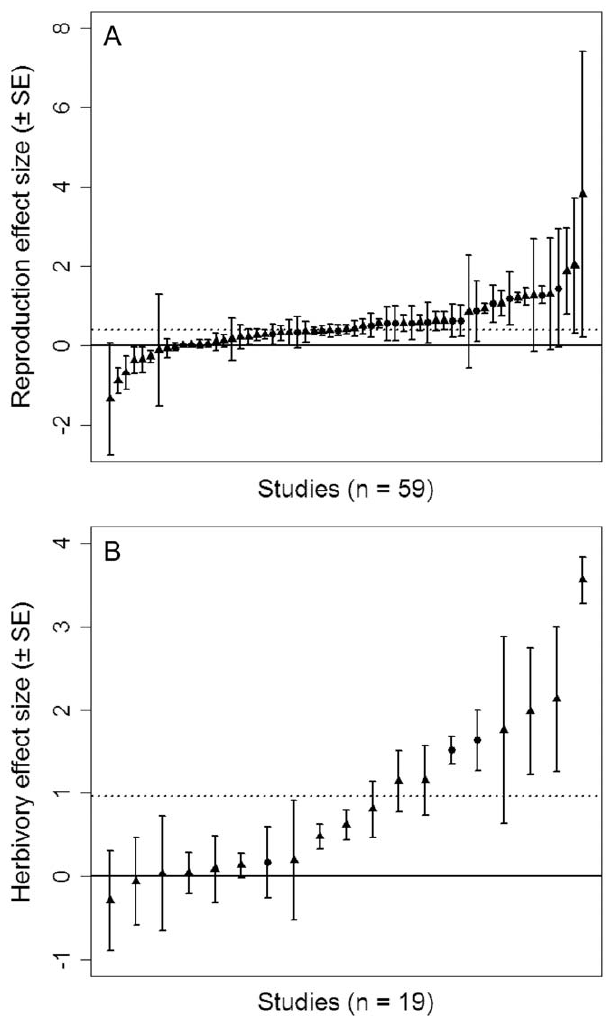
Figure 1. Effect sizes (means ± 95% confidence intervals) for responses of (A) plant reproduction and (B) herbivore damage to ant presence, ordered by magnitude. For both panels, the solid line indicates no effect (log-ratio =0) and the dashed line indicates the weighted mean effect size. Circles represent observational studies and triangles represent experimental studies; note that the y -axis scales are different for (A) and (B).